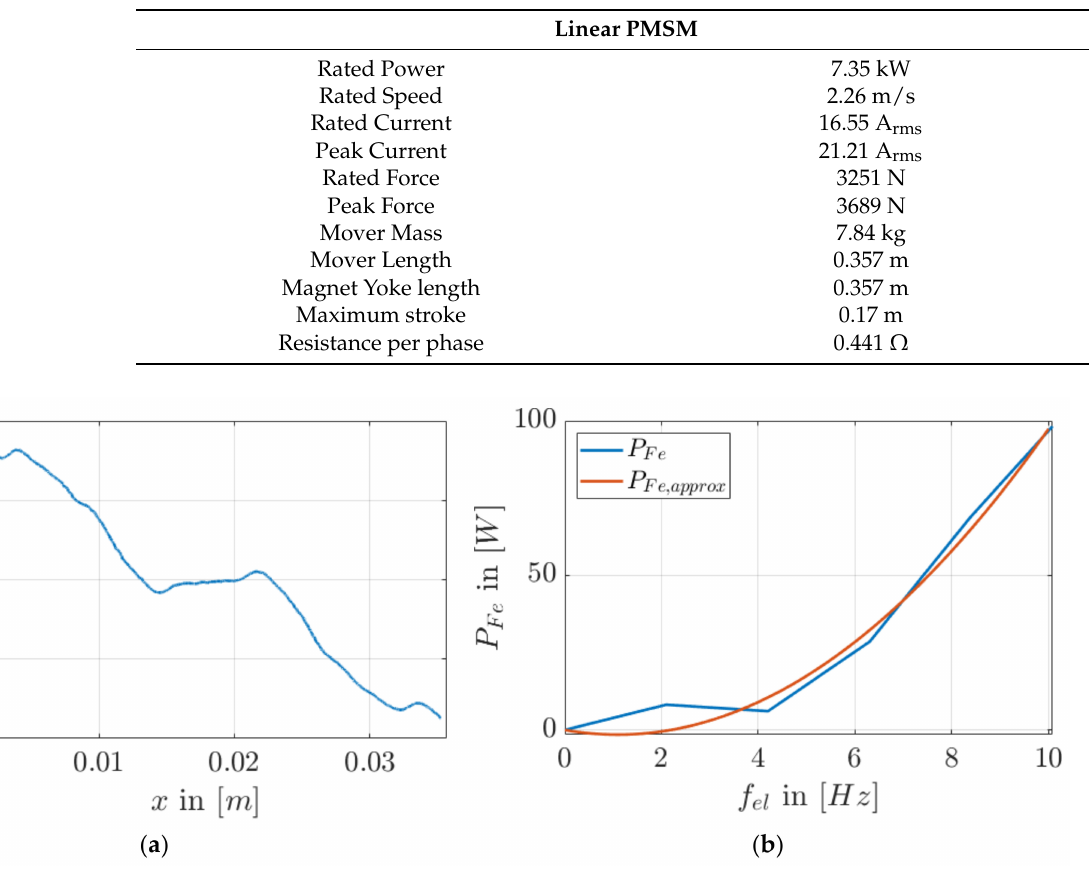
Figure 4. ( a ) Reluctance force F Rel depending on the position x . ( b ) Iron power losses P Fe depending on frequency f el